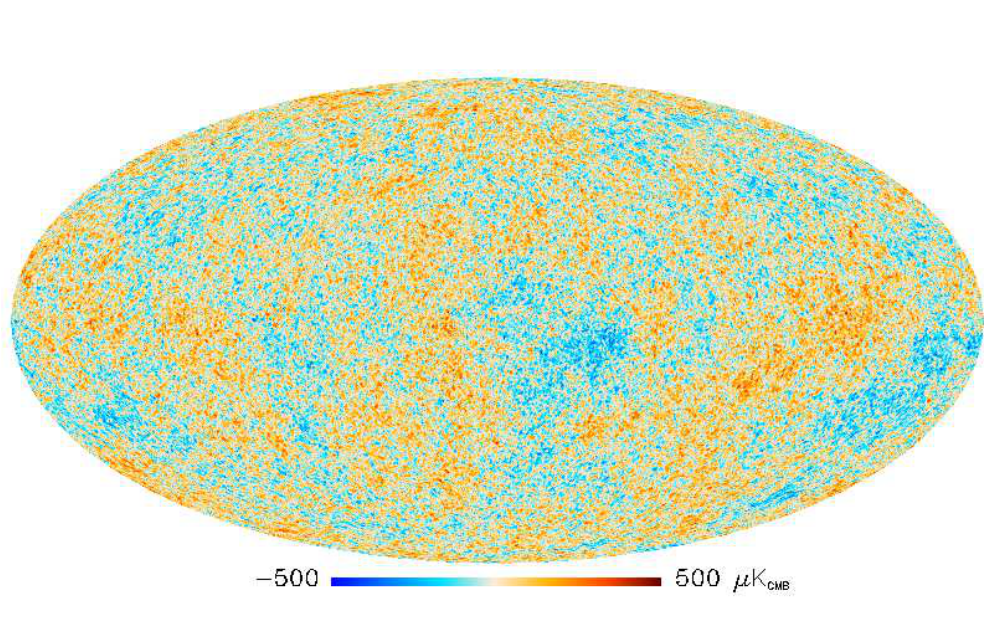
Figure 1: The SMICA method estimates the CMB over about 97% of the sky, with the remaining area replaced with a constrained Gaussian realization. Figure taken from Planck Collaboration I (2013).